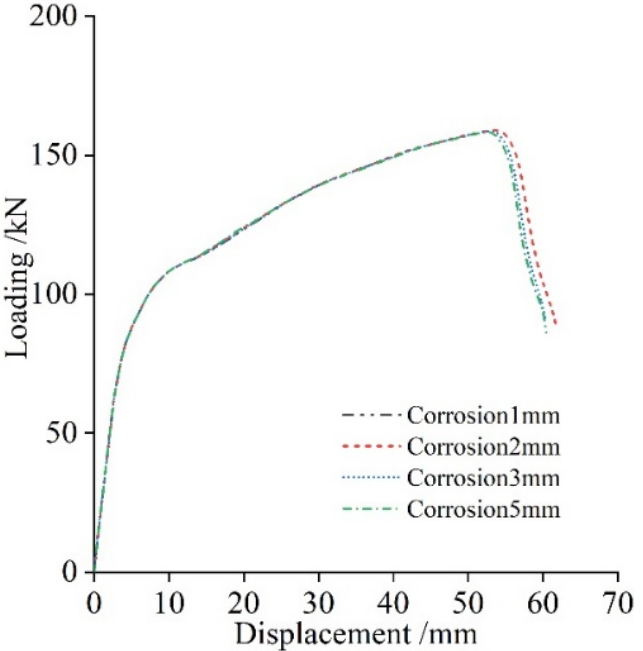
Figure 19. Load–displacement curves of different corrosion thicknesses.